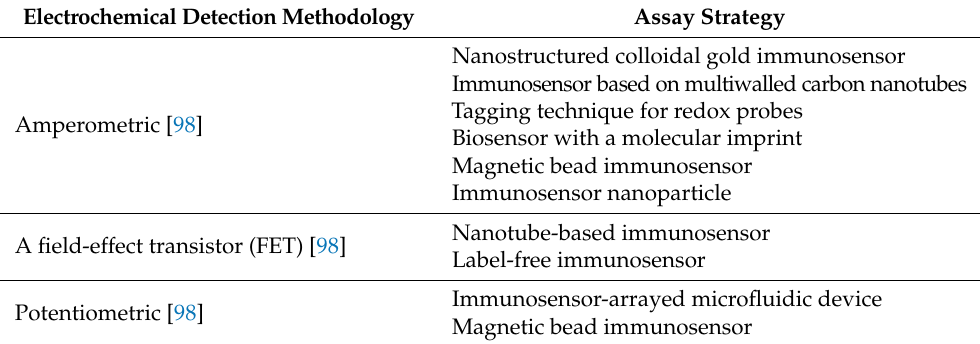
Table 3. Electrochemical detection